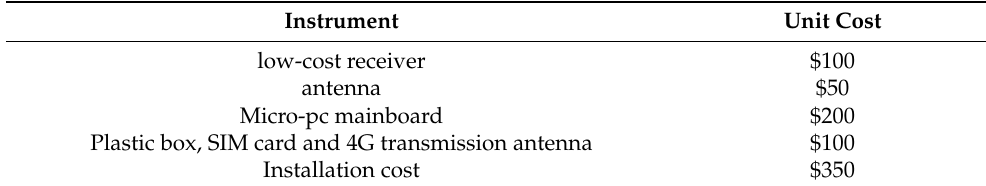
Table 1. The detailed cost of instrumentations and installation at the bridge monitoring station.